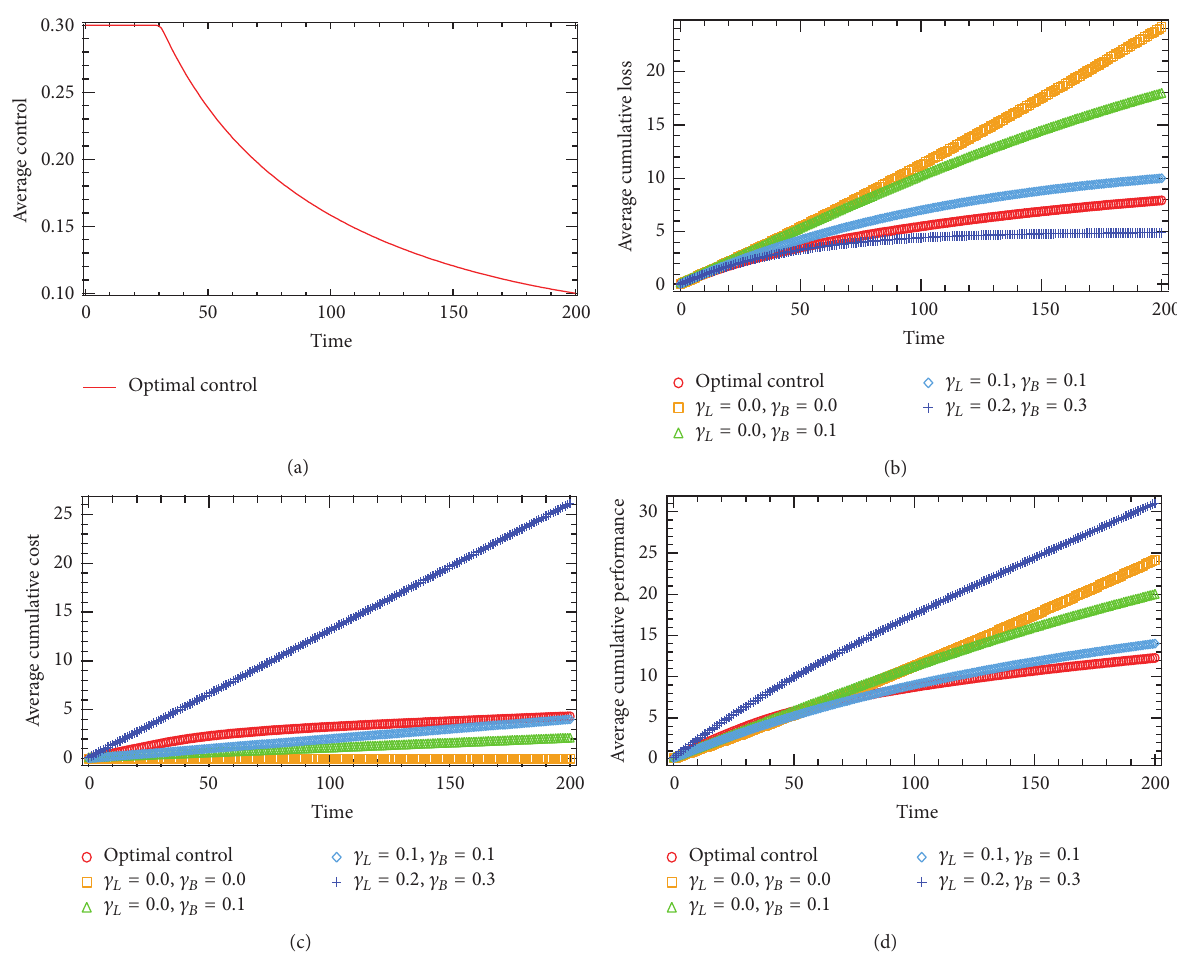
Figure 3: (a) The AC functions, (b) the ACL functions, (c) the ACC functions, and (d) the ACP functions for the optimal dynamic control strategies in Example